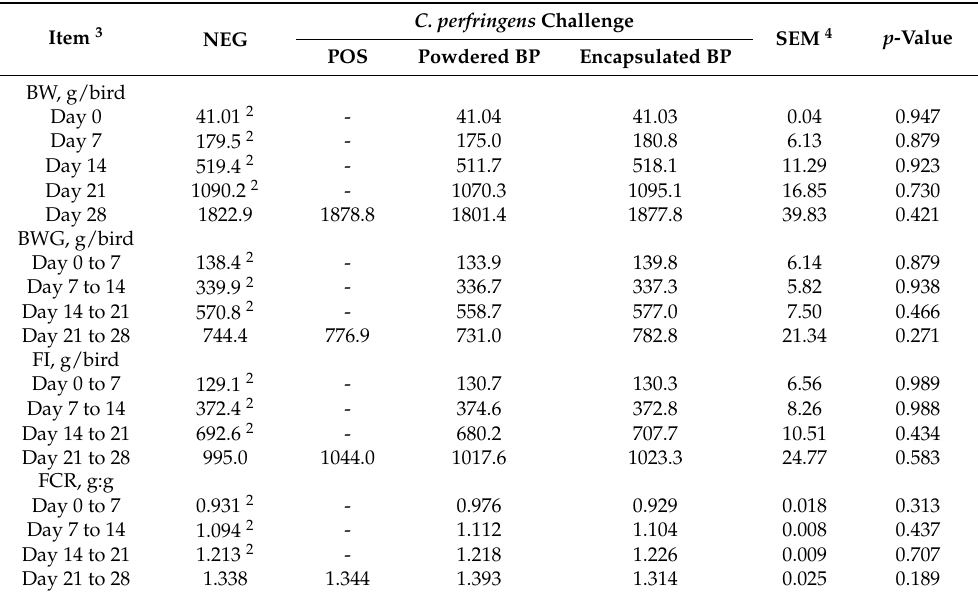
Table 2. Effects of dietary encapsulated and powder bacteriophages (BPs) on the growth performance of broiler chickens before and after challenge with Clostridium perfringens 1 .